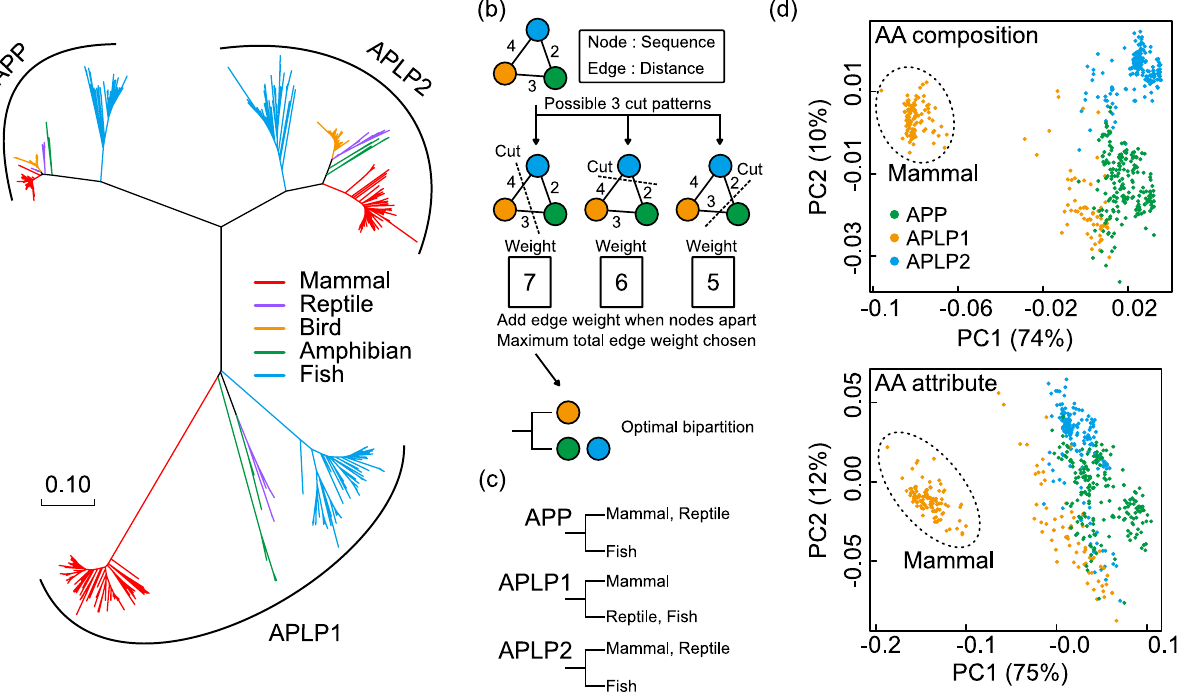
Figure 2. Difference in protein sequences of mammalian APLP1 among APP family. ( a ) The phylogenetic tree of the vertebrate APP family (protein sequence) was constructed using the neighbor-joining method. The mammalian stem for APLP1 shows a longer branch compared to APP/APLP2 consistent with nucleotide phylogenetic tree. ( b ) Overview of the max cut problem: the edges (distance) between partitioned nodes (sequence) are summed. The solution to the problem is to maximize the edges by searching for an optimal combination of bipartition. ( c ) Max cut problem was applied to the clustering protein sequence of APP family using digital annealer (Fujitsu, Japan). While mammalian APLP1 was clustered with the fish APLP1. ( d ) PCA applied to protein sequences of vertebrate APP family. 2 panels show the PCA of APP family described by amino acid (AA) composition and AA attribute, respectively. Descriptors for each sequence were calculated at ProtrWeb. Sequence in dotted circle represent mammalian APLP1, isolated from the other APP